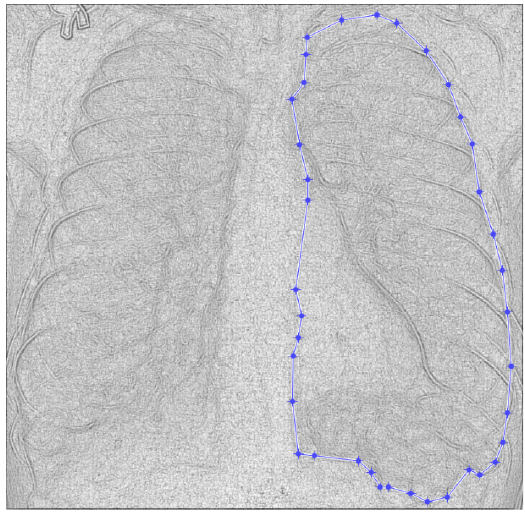
Figure 9. De fi ning the mask for the left lung of the second patient.